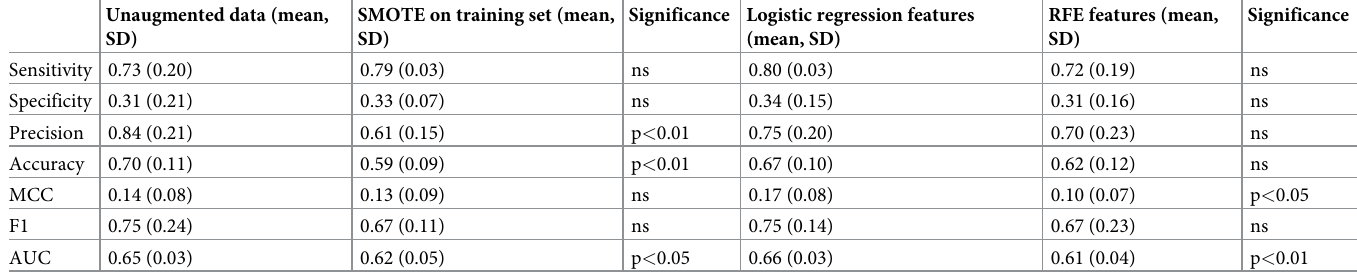
Table 5. Differences in mean performance results across all applied algorithms. AUC, area under the receiver operating characteristic curve. MCC, Matthews correla- tion coefficient. ns, not significant. RFE, recursive feature elimination. SD, standard deviation. SMOTE, synthetic minority oversampling technique. Unaugmented data (mean, SMOTE on training set (mean, Significance Logistic regression features RFE features (mean, SD) SD) (mean, SD) SD)